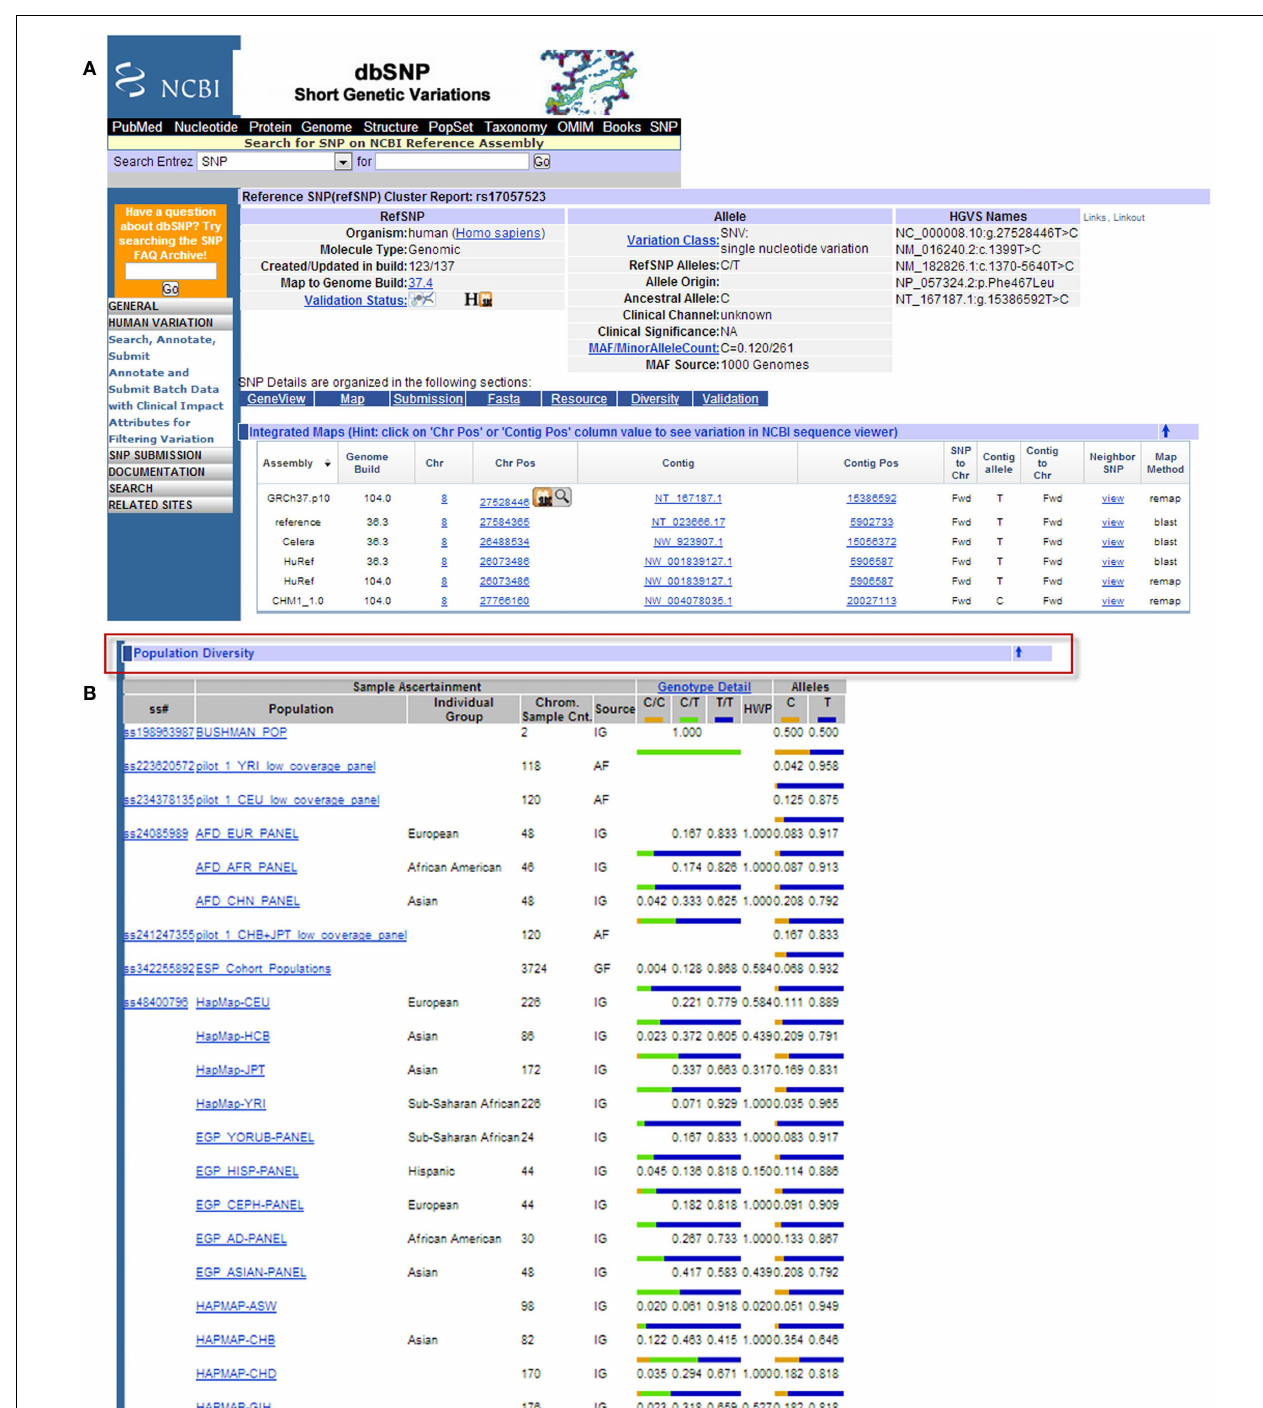
show more information regarding the SNP that may be useful to investigators. The “ Population Diversity ” section displays information regarding allele frequencies from different sampled populations (B) . Clicking any of the population links shows information on how the SNP was genotyped, the population sample size, and other experimental conditions